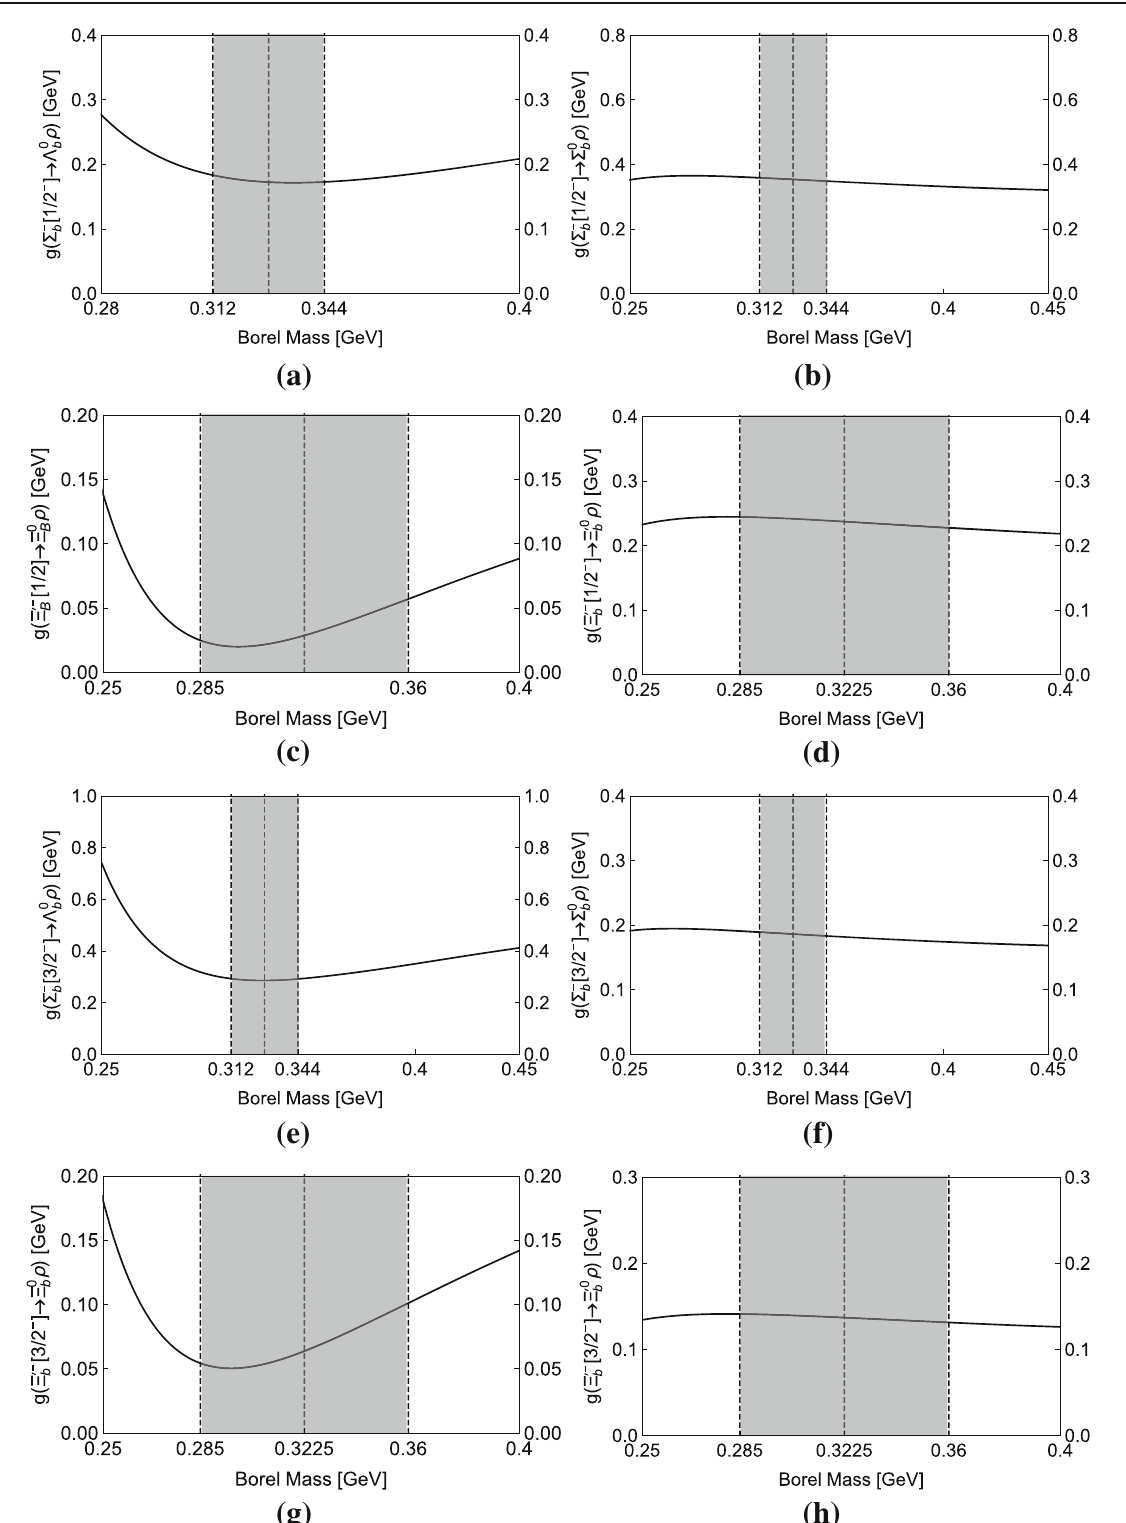
− / 3 − ) − / 3 − ) ( 1 and Ξ (cid:4) b 2 2 2 2